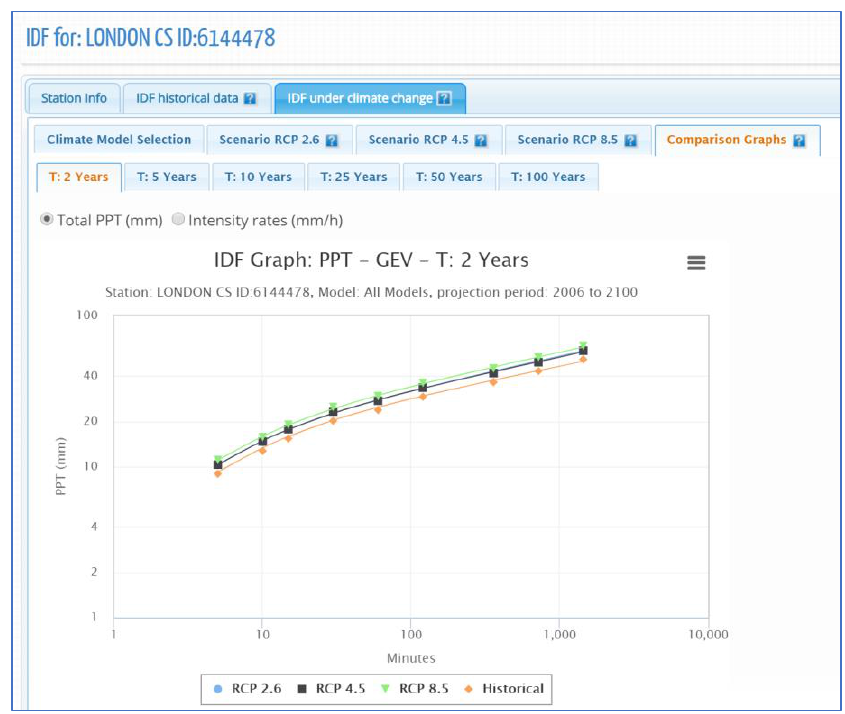
Figure 15. Comparison graph to assess the impact of different RCPs.